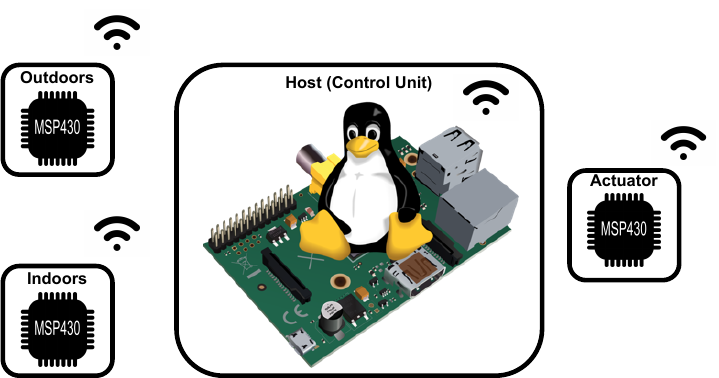
Figure 3. Illustrative diagram of the actuator system used during the real-word evaluation.